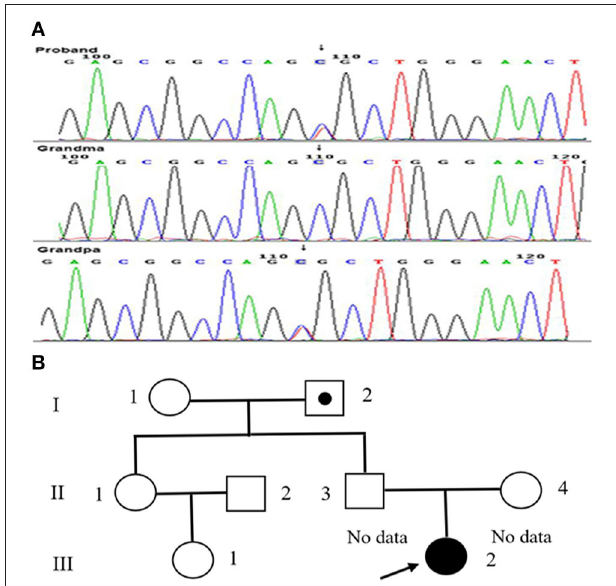
FIGURE 2 | Mutation dictation of APOE and family pedigree of our patient. (A) The mutation in the patient (arrow). (B) The family pedigree of the patient. Proband III-2 is the present patient (arrow). Circles and squares indicate the females and males, respectively. The dotted symbol represents asymptomatic LPG carriers. II-1 and II-2 did not undergo genetic testing for special reasons, both of whom had no history of renal disease.